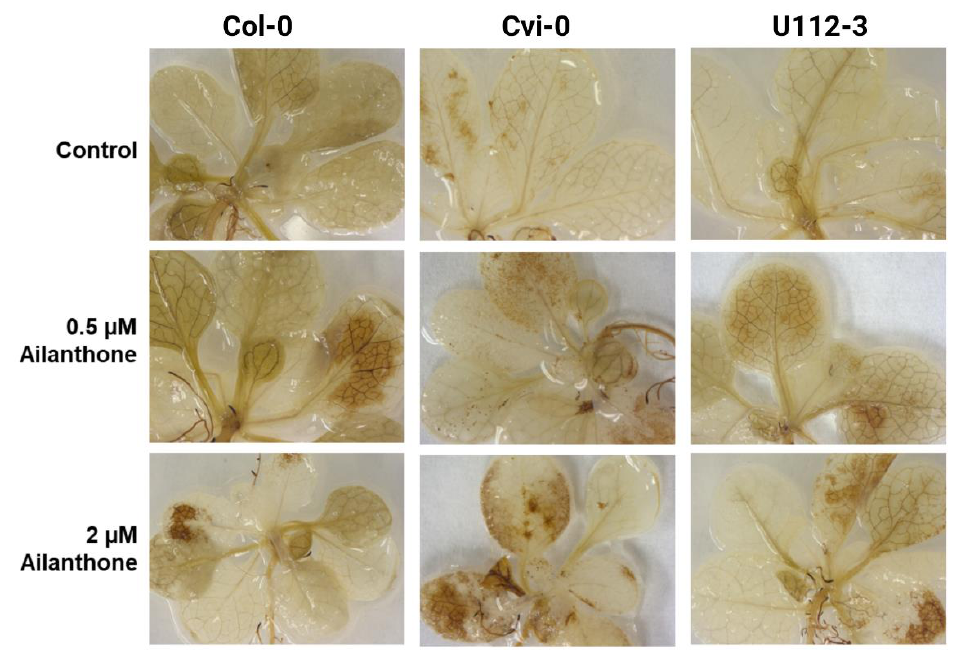
Figure 5. Ailanthone-treated seedlings accumulate excessive ROS. DAB staining of MS-grown 12- day-old Col-0, Cvi-0, and U112-3 seedlings shifted to the MS medium supplemented with mock (control), 0.5 and 2 µM ailanthone for a week.